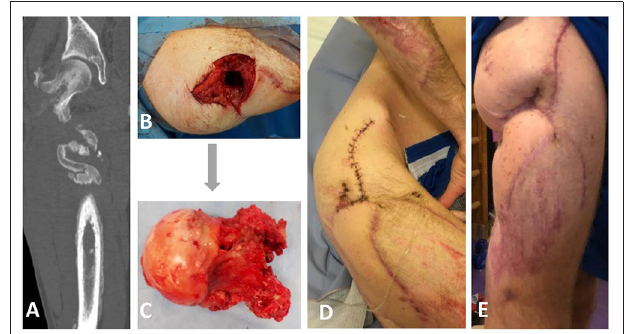
FIGURE 1 | Clinical and radiological appearance of the patient prior, during, and after bacteriophage therapy. (A) Computed tomography revealing a fistula that connects femoral head and skin on the right upper third of the lateral femur surface. (B,C) Intraoperative findings from the right femoral